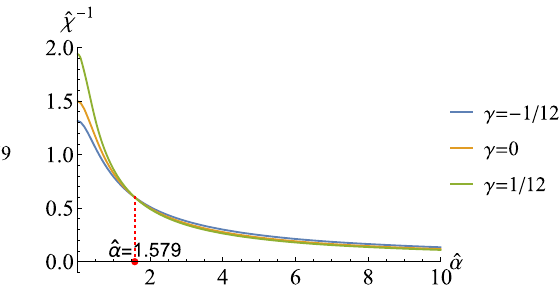
for some fixed Weyl coupling parameter γ . (For interpretation of